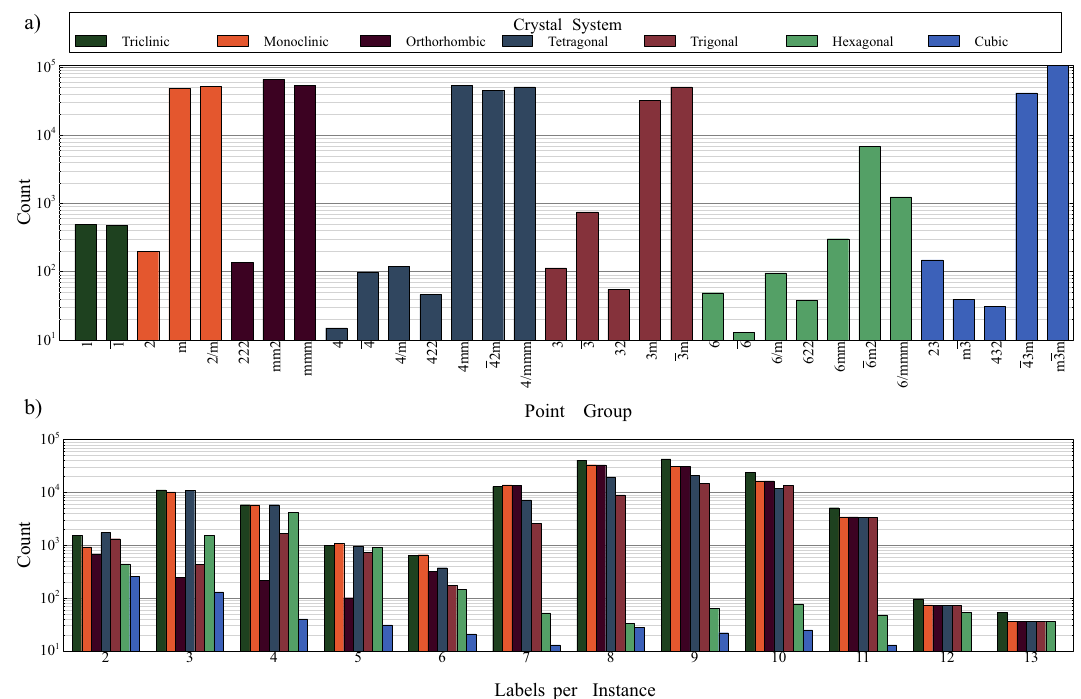
Figure 2. The distribution of the acquired structural data for 610,759 ternary materials. ( a ) The distribution of the structural data w.r.t the point groups where the corresponding crystal system is identified; and ( b ) The distribution of the multi-label chemical formula for every crystal system. For most of the number of instances, triclinic crystal system is the highest populated system while ternary materials with cubic crystal system are the least frequent to occur. The majority of the multi-label material space span between 7 and 11 labels per